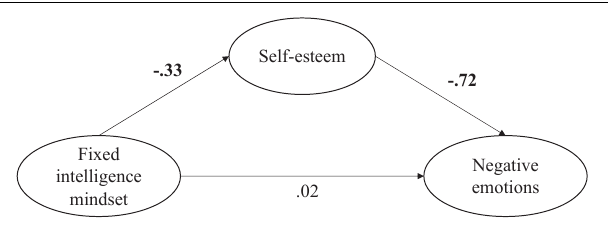
FIGURE 1 | Mediational model. All variables presented in ellipses are latent variables. For the sake of simplicity measured variables are not depicted in this figure. One-headed arrows represent standardized regression weights. Significant regression weights are in